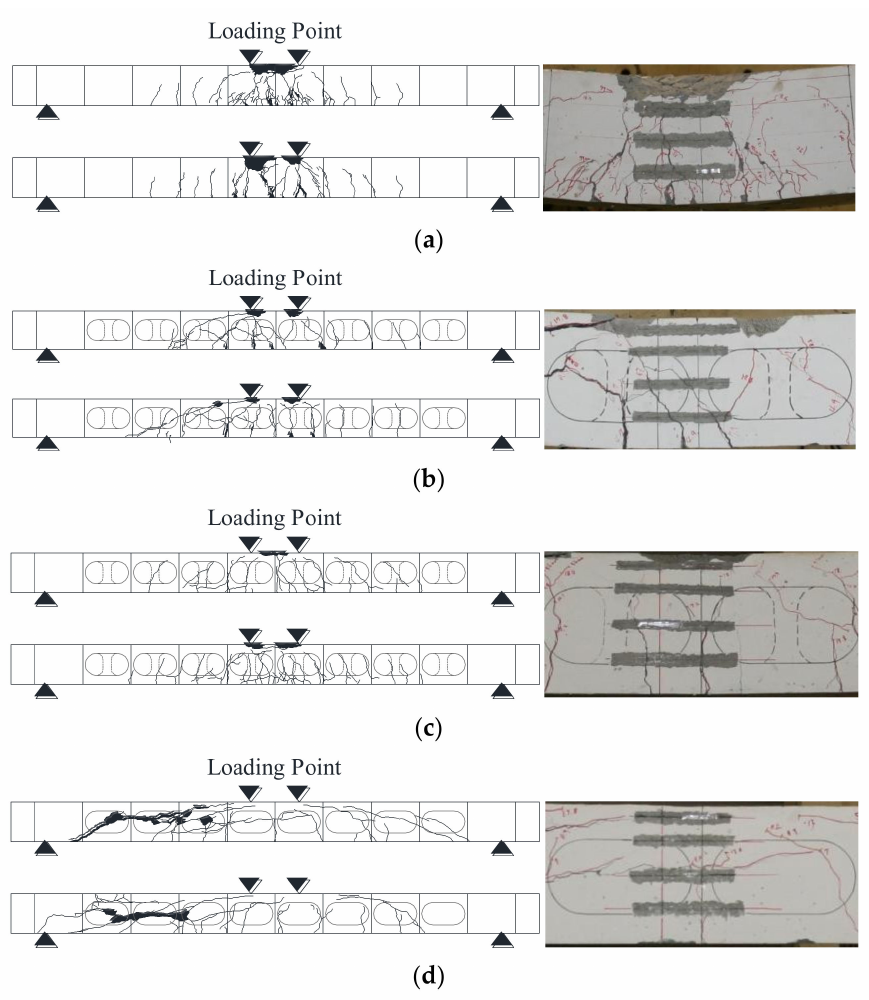
Figure 12. Crack pattern and failure mode. ( a ) Solid; ( b ) OF-V-S-D; ( c ) OF-V-M-D; ( d )